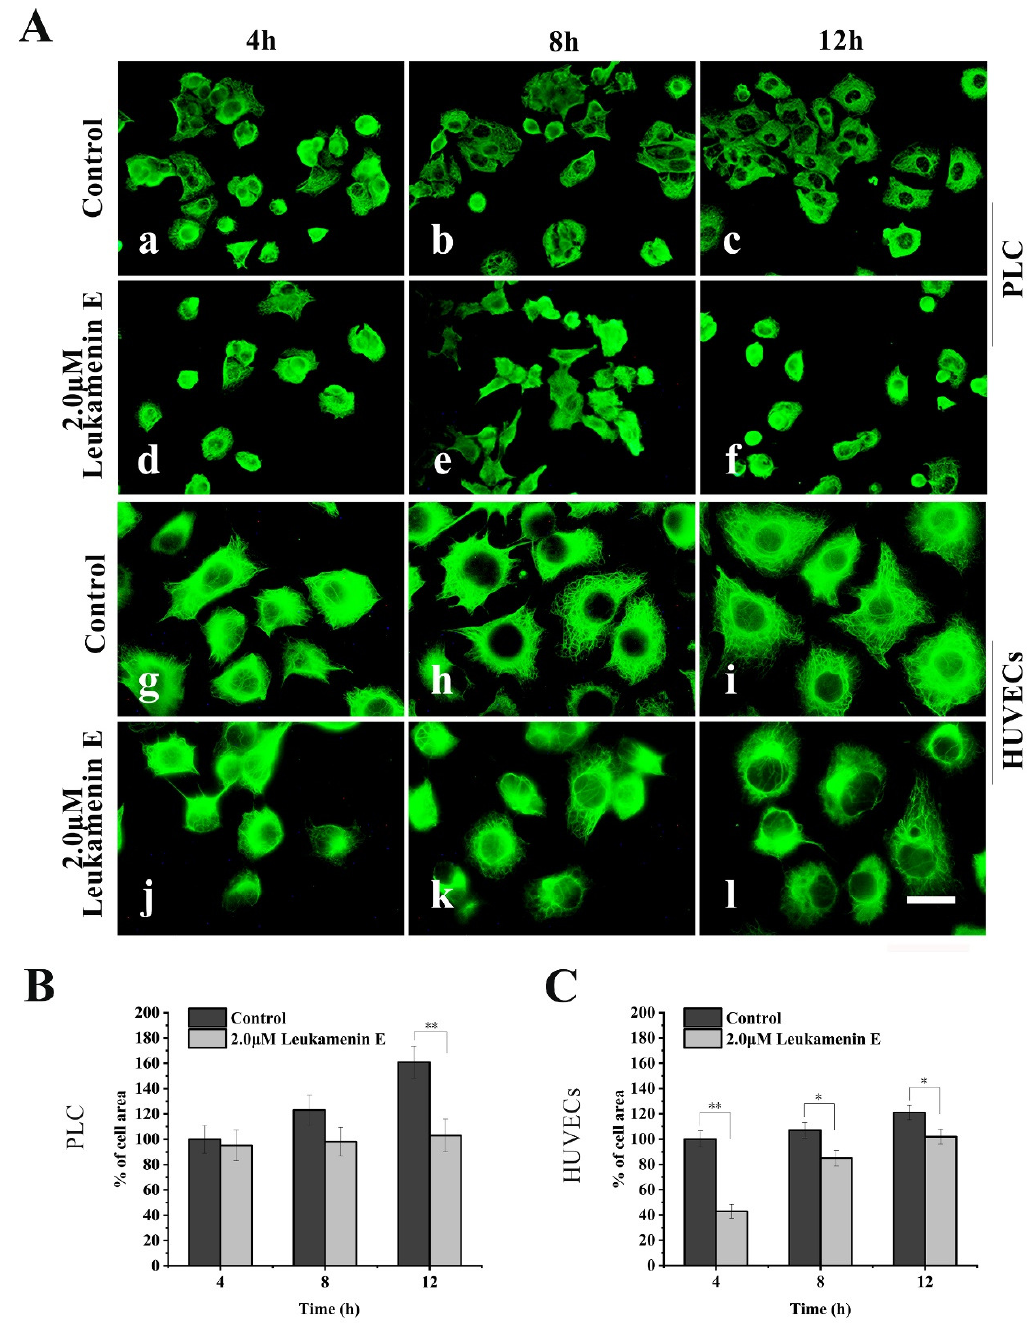
Figure 5. Leukamenin E inhibits KFs reassembly and cell spreading in HUVECs and PLC. ( A ) Representative images of KF network reassembly and cell morphology at 4–12 h after the suspended PLC and HUVECs were seeded in media with leukamenin E (d,e,f,j,k,l) or DMSO (control, a,b,c,g,h,i), showing the inhibition effect of leukamenin E on KFs reassembly and cell spreading. 1000 ×, Bar, 10 μm. ( B ), ( C ) Areas of cell spreading were measured at 4 h, 8 h, and 12 h after suspended HUVECs or PLC were seeded in medium-containing leukamenin E or DMSO (control). Images represent typical cells from at least three independent experiments. The data shown represent the means ± standard deviation (S.D.) of three independent experiments. * p < 0.05, ** p < 0.01, νersus the control group.